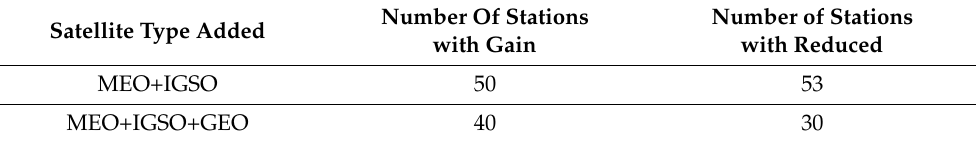
Figure 4. Geographical distribution of positioning accuracy of 145 tracking stations in 3D with IGSO and GEO satellites added to MEO. Table 2. The number of accuracy improvements of adding IGSO in MEO and GEO in MEO and IGSO.